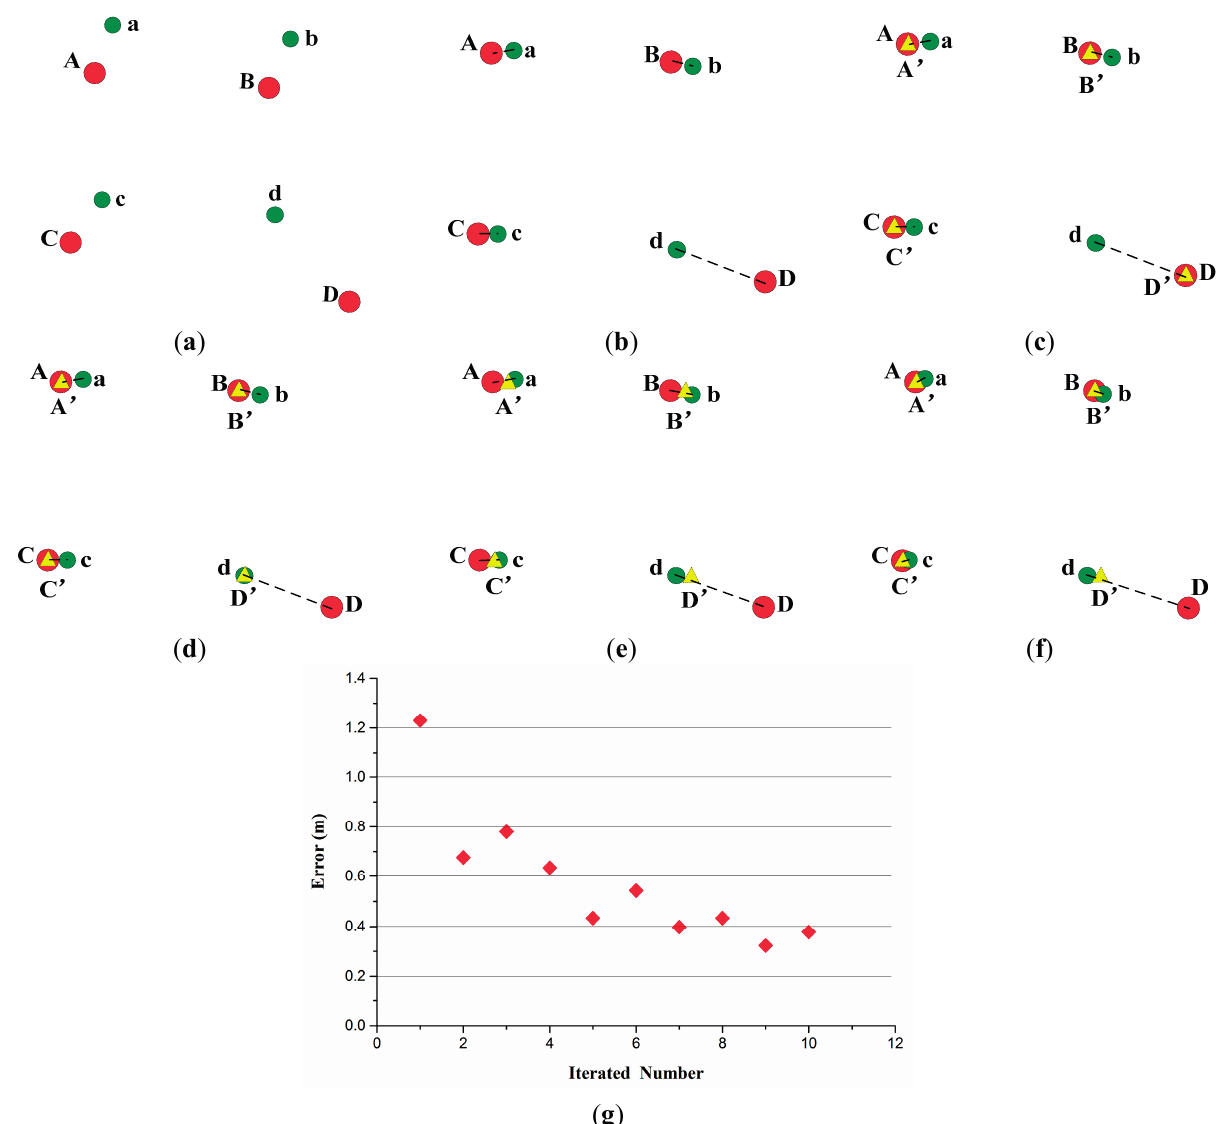
Figure 4. A shiftable leading point method (airborne corners: red circles; terrestrial corners: green circles; leading point: yellow triangles). ( a ) Original airborne and terrestrial corners; ( b ) airborne and terrestrial corners after registration; ( c ) generated leading points from airborne corners; ( d ) shift of a leading point; ( e ) registration of leading points and terrestrial corners; ( f ) transformation of airborne corners with the registration matrix in (e); ( g ) change of the geometric error of leading points and terrestrial corners with